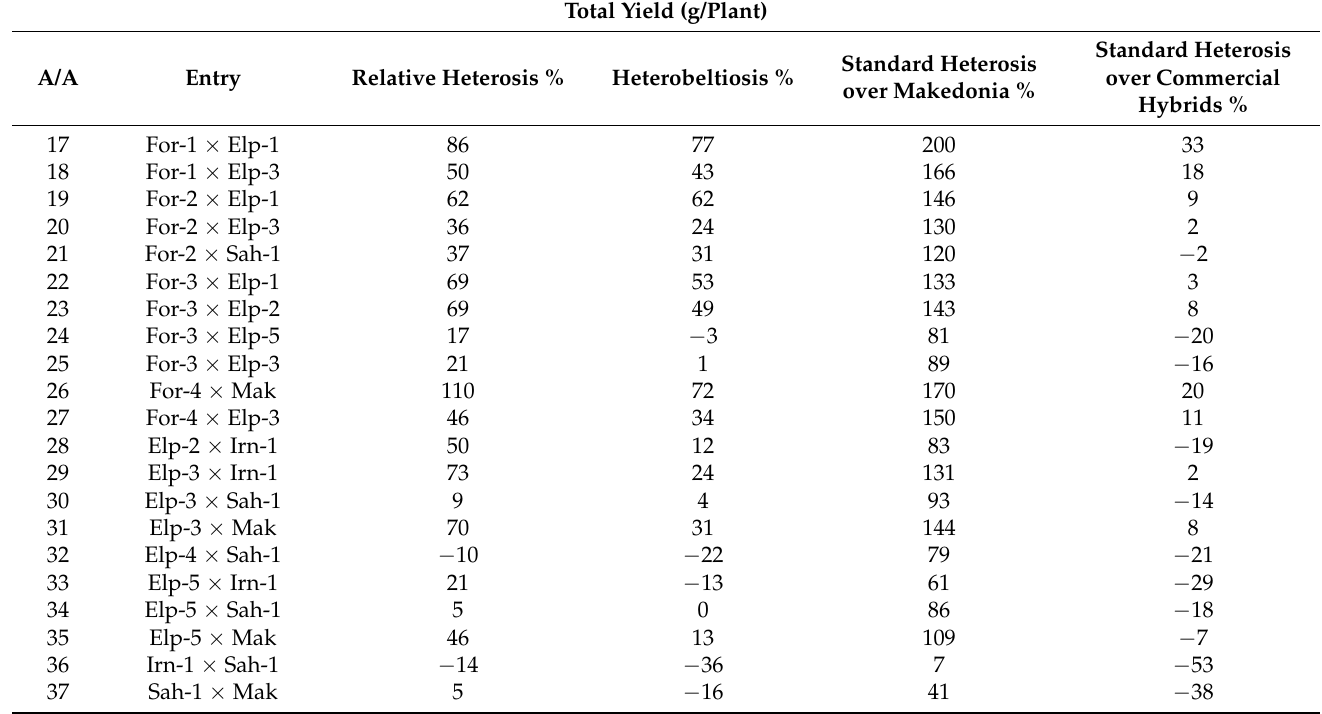
Table 5. Relative heterosis, heterobeltiosis, and standard heterosis of the reconstructed new hybrids for total yield (g/plant). Total Yield